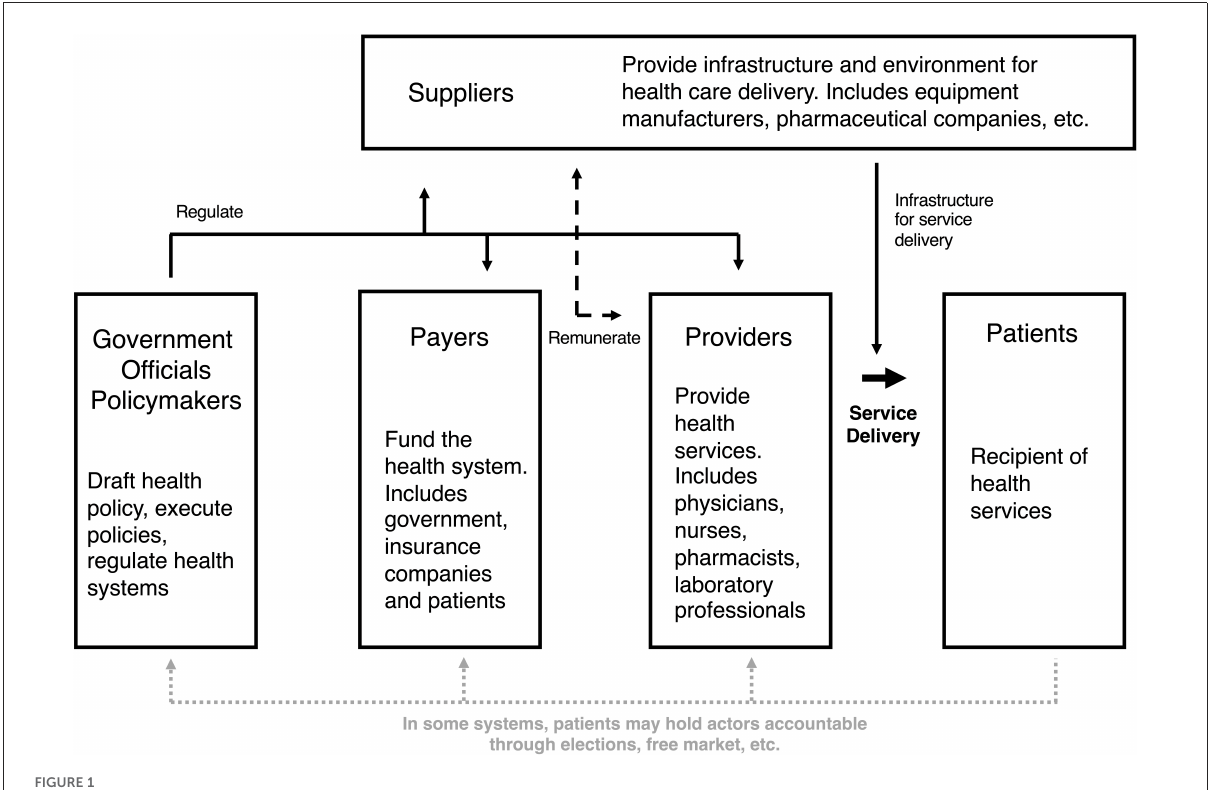
FIGURE1 Schematic diagram of actors in the health system along the continuum of service